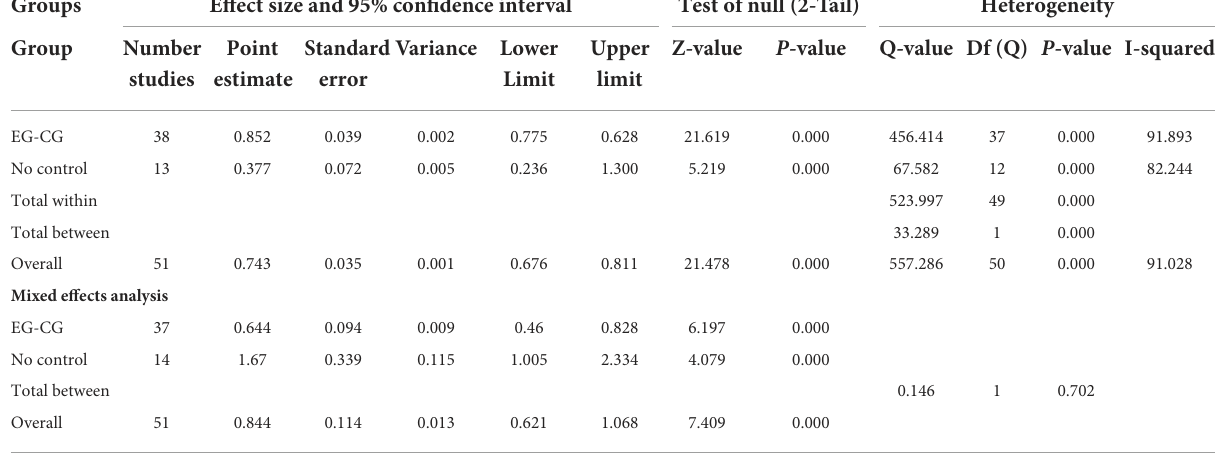
TABLE 7 Moderator analysis of experimental design.